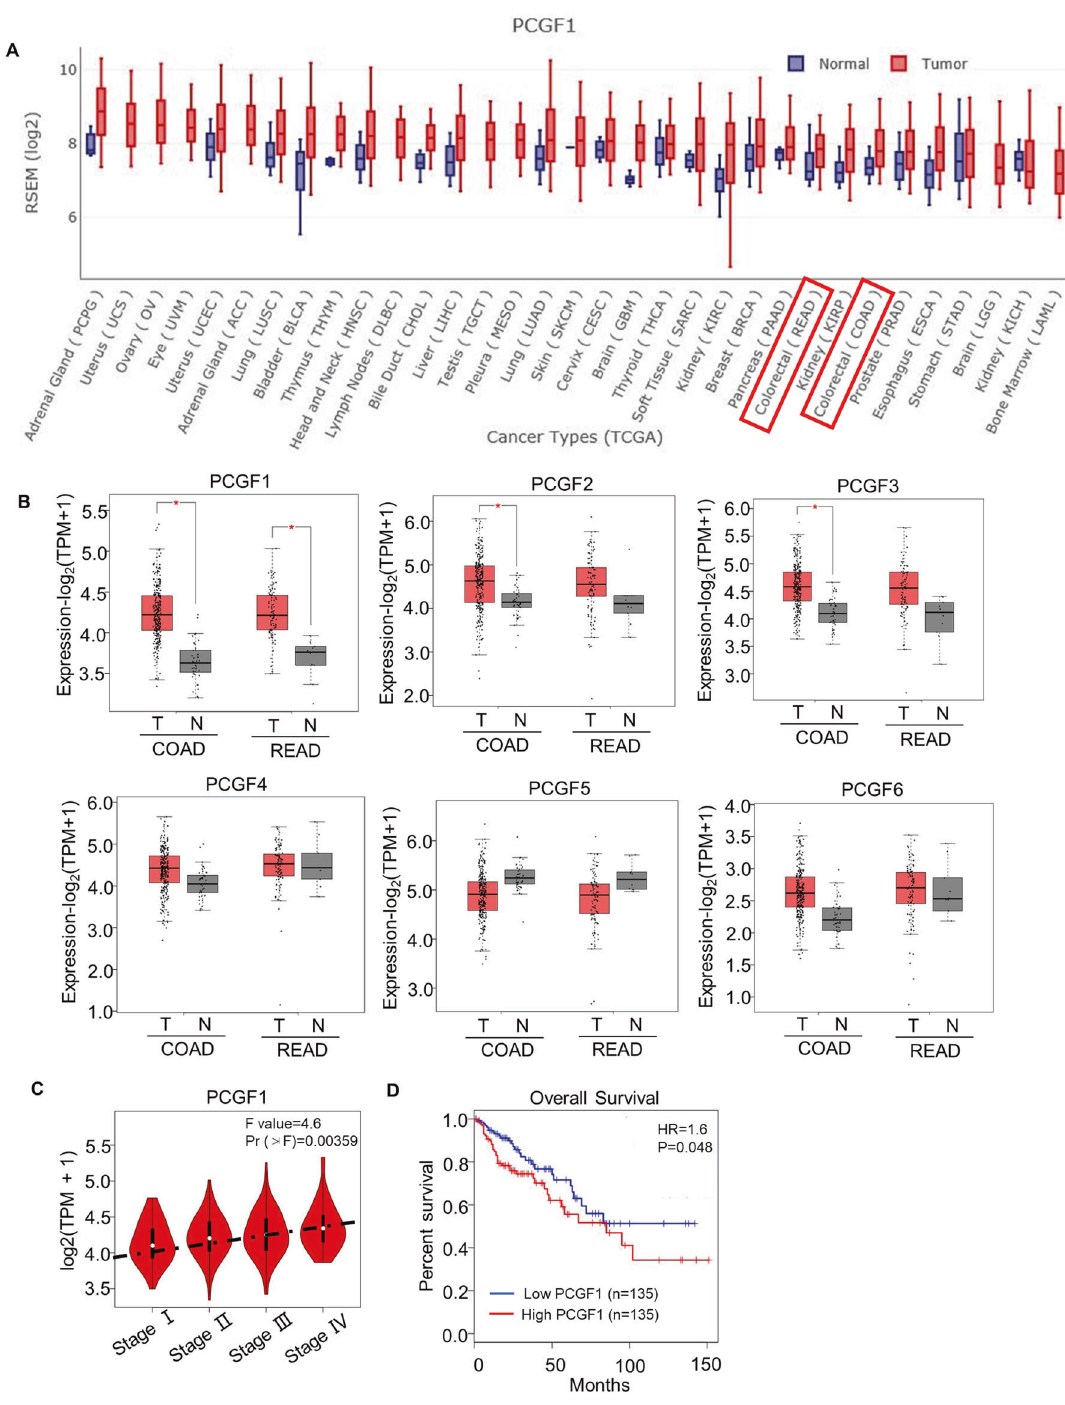
Fig. 1 PCGF1 is upregulated in colorectal cancer. A Expression of PCGF1 in different types of tumours in the GEDS database. The red boxes refer to colorectal READ and COAD. B Expression of PCGF1-6 in colorectal cancer in the GEPIA database. COAD (num(T) = 275; num(N) = 41), READ (num(T) = 92; num(N) = 10). T, tumour; N, normal. C PCGF1 expression levels in specimens with various clinical stages. D Kaplan – Meier analyses of the OS rate in CRC patients in the GEPIA database with high or low expression of PCGF1 ( n = 135, log-rank test). The hazard ratio (HR) and P value (log-rank test) for each comparison are the relationship between PCGF1 expression and tumour malig- PCGF1 is highly expressed in colorectal cancer stem cells nancy, we used sphere cultures to induce spheroid body To verify the results predicted by database analysis, we compared formation in HCT116 colorectal cancer cells to enrich CSCs (Fig. the mRNA and protein expression of PCGF1 in HCT116, SW480, 2C). The stem cell-related properties of the spheroids and the SW620, DLD-1 and LoVo CRCs with that in HCoEpiCs (normal adherent cells were further examined via the stemness-related intestinal epithelium cells) and found that PCGF1 was more highly markers CD133, CD44 and LGR5 through RT-qPCR and expressed in CRCs than in HCoEpiCs (Fig. 2A, B). To further explore